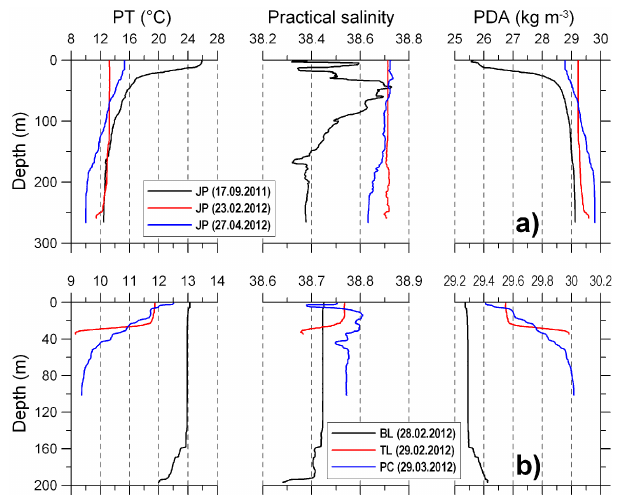
Fig. 2. Vertical profiles of potential temperature, practical salinity and potential density anomaly at selected stations along the east- ern Adriatic coast: (a) JP on 17 September 2011, 23 February 2012 and 27 April 2012; (b) BL on 28 February 2012, TL on 29 Febru- ary 2012 and PC on 29 March 2012.